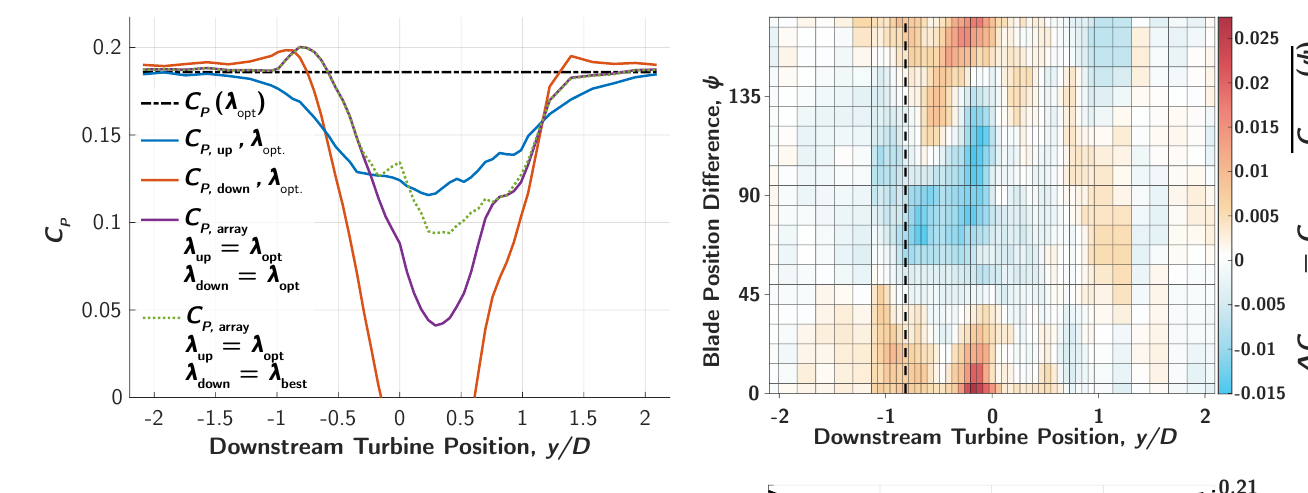
Fig. 6. Summary of uncoordinated operation results from the coordinated control experiment. The optimal tip-speed ratio for a single, isolated turbine is λ = λ opt. . The black dashed line, C P ( λ opt ) indicates the performance of a single, isolated turbine at this tip-speed ratio. The blue and red lines, C P, up and C P, down , indicate the individual performance of the upstream and downstream turbines respectively, with both turbines operating at λ = λ opt. . Here, we have averaged performance over all blade position differences tested. We feel that this simulates uncoordinated control, as if the blade position difference was not dictated by a parent controller. The purple line is the array performance, Eq. (7), for these same conditions. The green, dashed line indicates peak array performance for the sweep of downstream turbine tip-speed ratios.